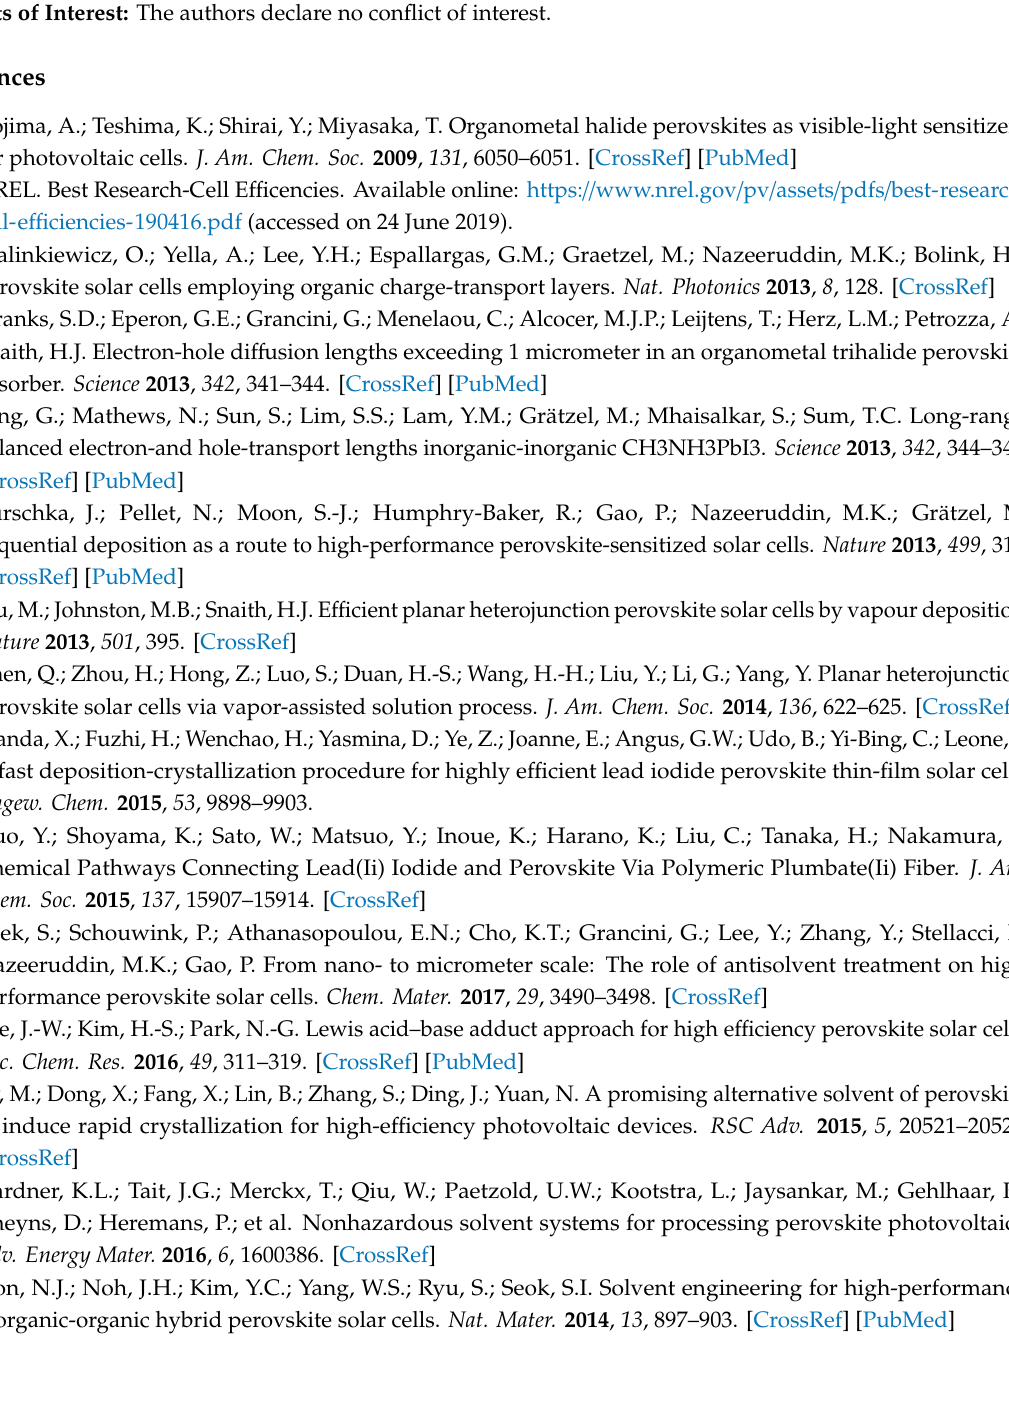
Figure S1: The ATR-FTIR spectra of hybrid FAMA cation and pure MA cation intermediate films, Table S1: The photovoltaic parameters of device fabraication by four precursors (0DMF,1DMF,2DMF and 3DMF), Table S2: The photovoltaic statistics of device by using di ff erent quantity of EA. Figure S2: The J-V curves of device by dripping chlorobenzene (CB) and methyl acetate (MA), Table S3: corresponding photovoltaic